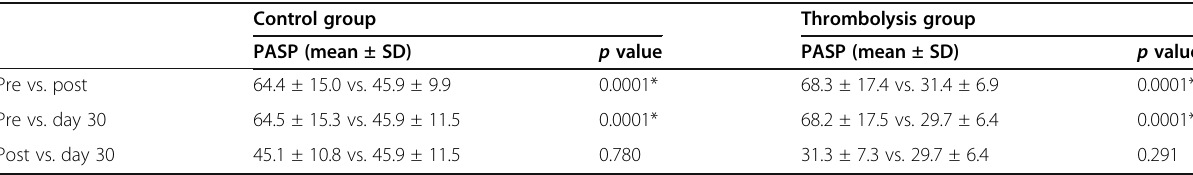
Table 5 Pulmonary artery pressures